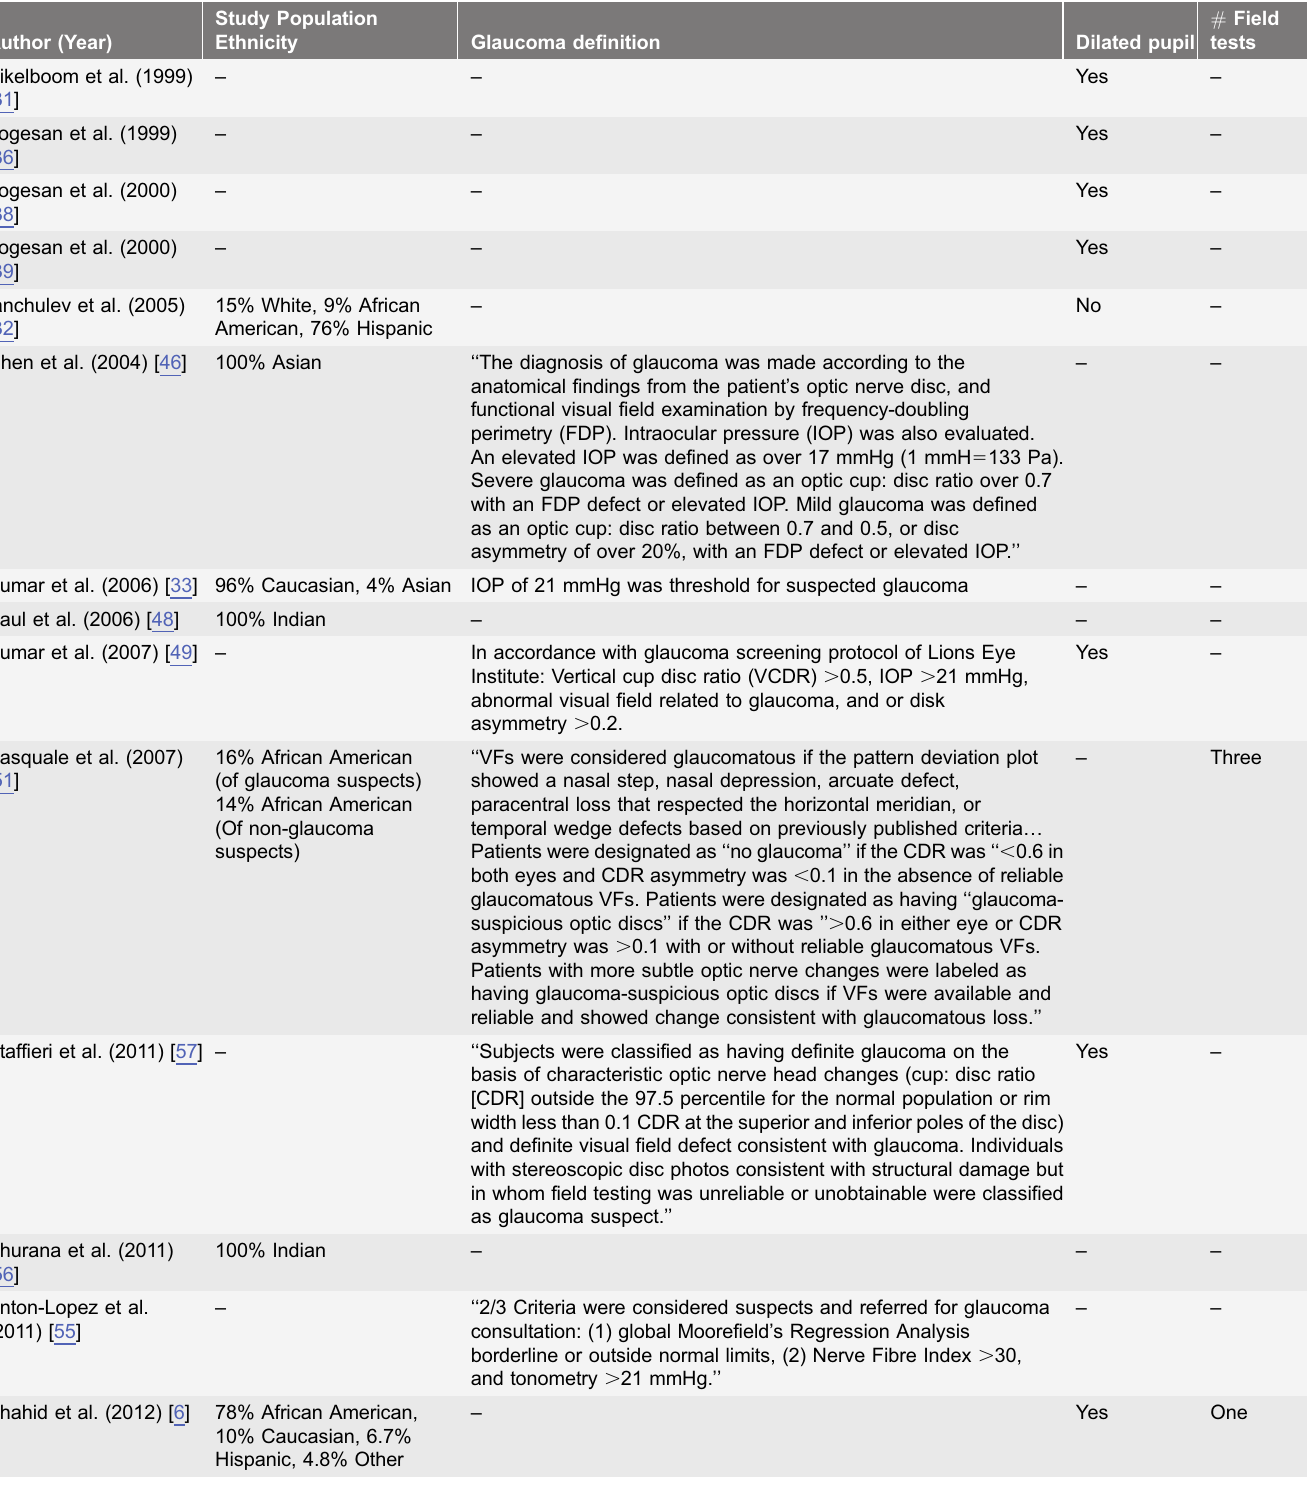
Table 4. Additional Details on Baseline Characteristics of Included